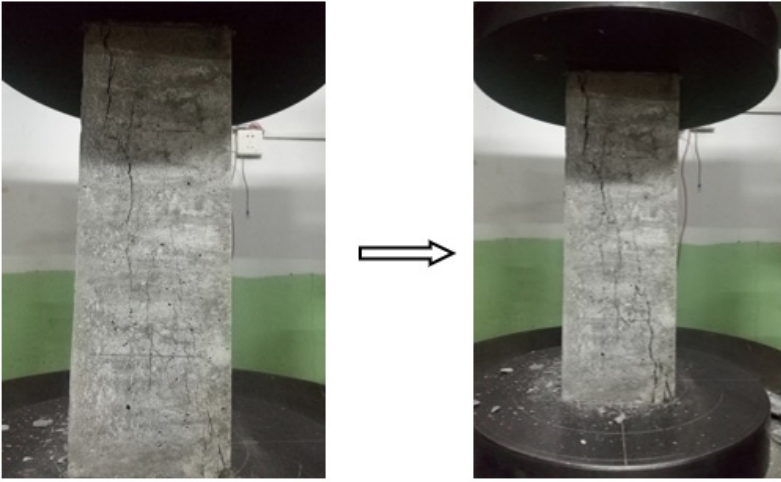
Figure 4. Crack propagation process of specimen in axial compression deformation test.